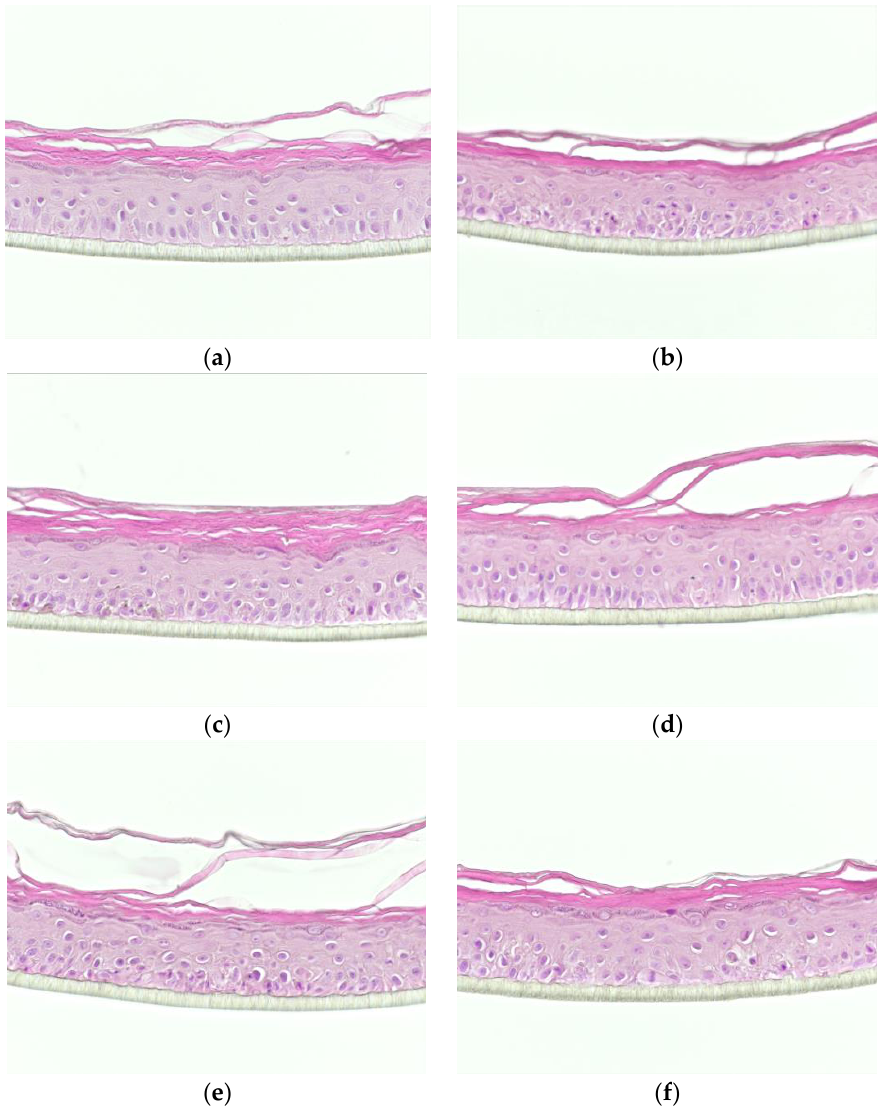
Figure 1. Histological sections of Th2-stimulated reconstructed human epidermis (RHE) after 48 h or topical and systemic treatments with the test compounds and reference of its solvent, respectively (H/E staining; n = 1). ( a ) control; ( b ) Th2 (+PBS topic); ( c ) Th2 + DMSO 0.05% ( d ) Th2 + 10 µM GW3965 in 0.05% DMSO; ( e ) Th2 + 100 µ/mL FV; ( f ) Th2 + 100 µ/mL UP. GW3965 in 0.05% DMSO; ( e ) Th2 + 100 µ /mL FV; ( f ) Th2 + 100 µ /mL